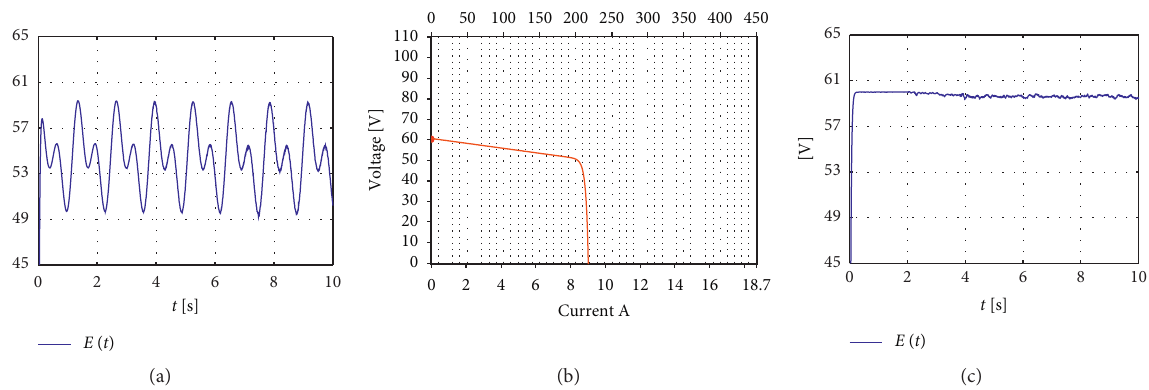
Figure 11: Renewable energy emulation of E ( t ) generated via the TDK-Lambda G100-17 programmable DC power supply. (a) Ex- perimental realization of the waveform (equation (24)) that contains some variations that could arise from the usage of a renewable energy source. Experimental implementation when the programmable DC power supply emulates the behavior of solar panels with constant radiation (equation (25)). (b) V-I curve of the TS-S425 solar panel and (c) dynamic behavior of the TS-S425 solar